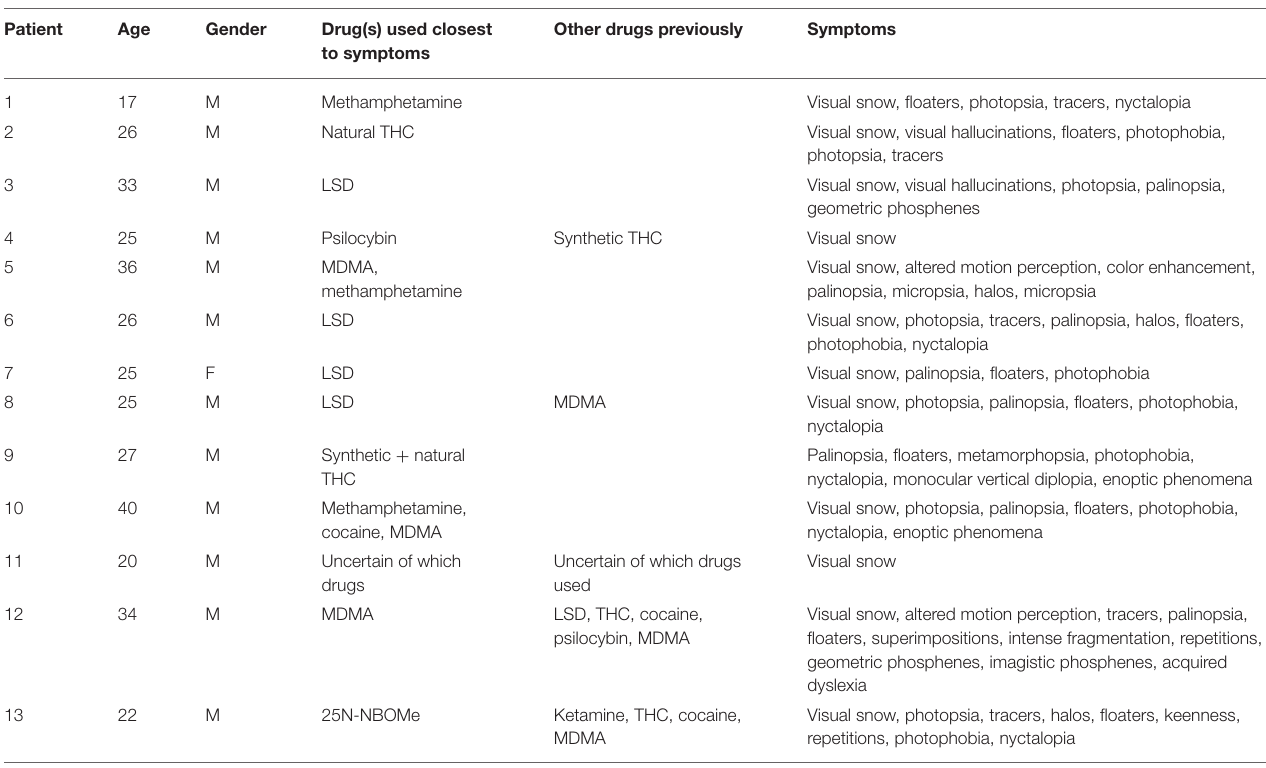
TABLE 2 | Characteristics of HPPD